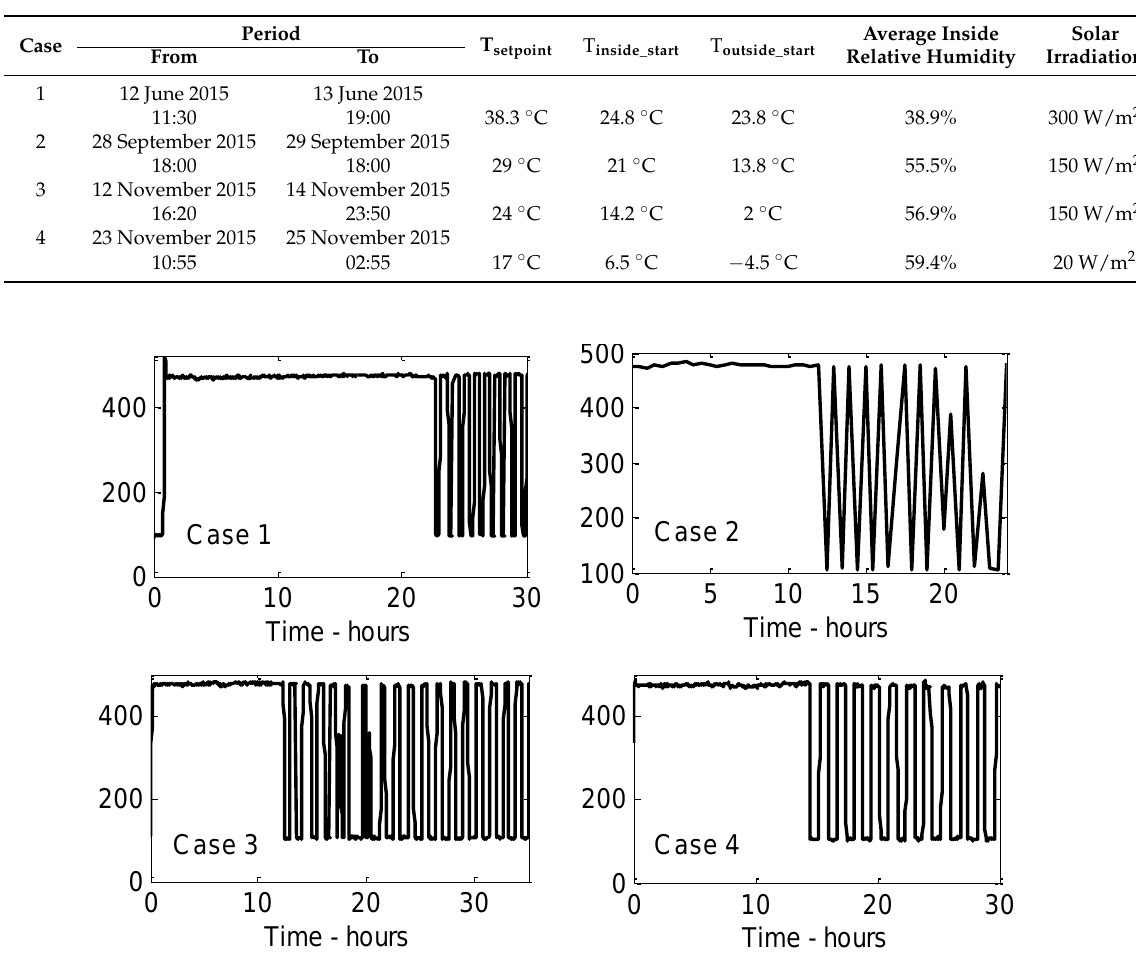
Figure 5. The measured power consumption pattern of each case study in